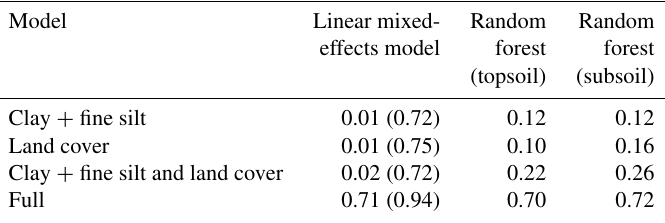
Table B3. Summary table of R 2 for the different models (linear mixed-effects model and random forest) with different explanatory variables (clay + fine silt, land cover, clay + fine silt and land cover and full) included for the entire data set. The R 2 in parentheses for the linear mixed-effects models refer to the conditional R 2 , which include the variation explained by the random effects (siteID/clusterID/plotID).